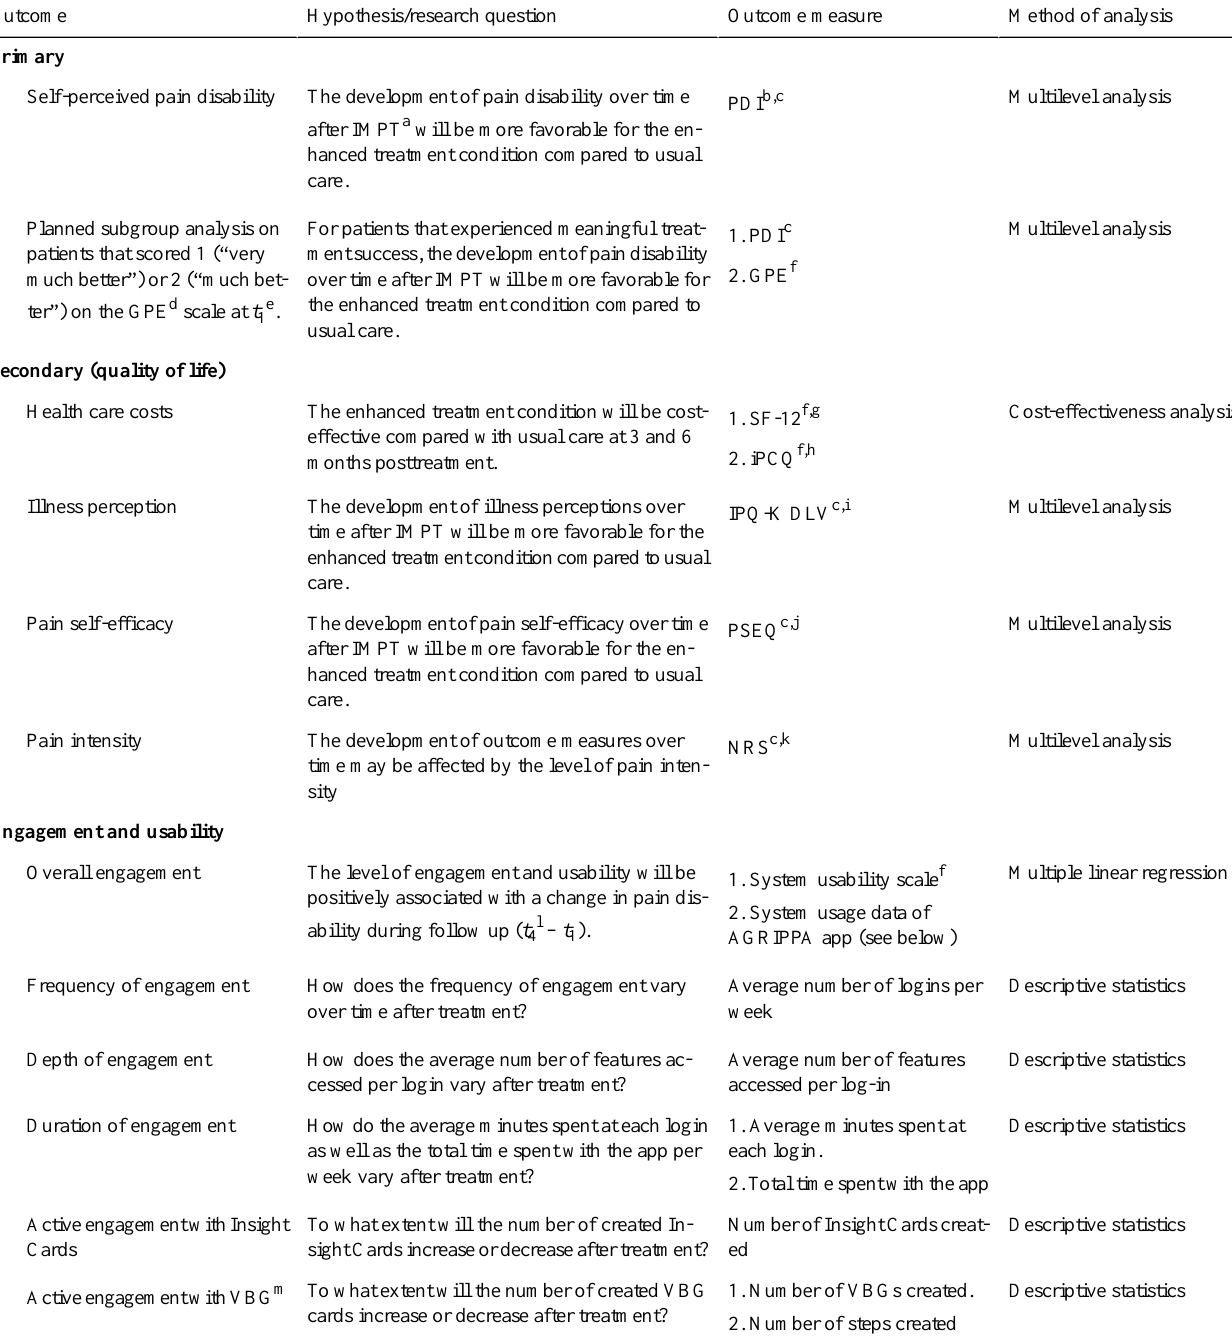
Table 1. Planned outcome domains, outcome measures, and statistical